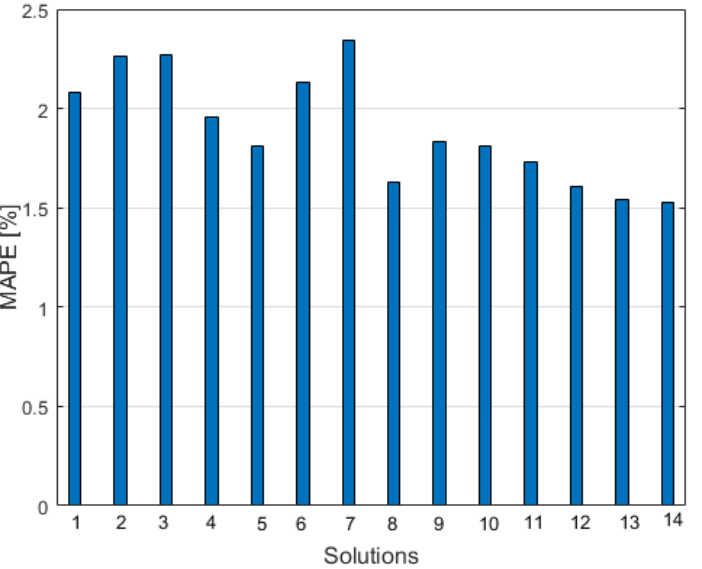
Figure 9. The comparison of MAPE values at the application of different individual tools as predictive units and their integration in the ensemble. The particular solutions are denoted by numbers from 1 to 14. LSTM is unbeatable in all cases.